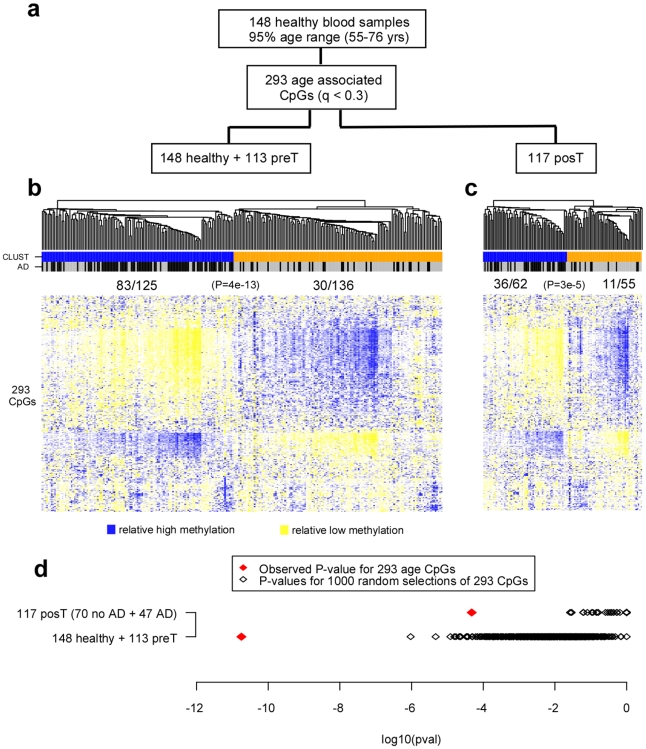
Clustering of samples over age-associated CpGs.
a) Multivariate linear regression of age in 148 healthy blood samples against CpG methylation profiles adjusting for BSC efficiency, batch and DNA input effects, identified 293 CpGs at q(FDR)<0.3. b) Hierarchical clustering of the 148 healthy controls and 113 pre-treatment (preT) cases over the 293 CpGs. The two main clusters (CLUST) predicted by the algorithm are labelled as blue and orange. Case control status is indicated as active disease (AD): case = black, control = grey. c) Hierarchical clustering of 117 post-treatment cases over same 293 CpGs. Of the 117 post-treatment cases, 47 and 70 had recurrent (black) and no recurrent (grey) active disease (AD) at sample draw, respectively. The two main clusters (CLUST) predicted by the algorithm are labelled as blue and orange. In the heatmaps, CpG specific methylation β-values were standardised to zero mean and unit variance for sake of clarity (blue: high relative methylation, yellow = low relative methylation). In panels b) and c) we give the number of samples with active disease at sample draw in each cluster, and give the corresponding Fisher's exact test P-value. d) Comparison of observed P-values with those obtained by 1000 random selections of 293 CpGs. P-values were computed from Fisher's exact test for the two clusters inferred from applying a Gaussian mixture model [43].